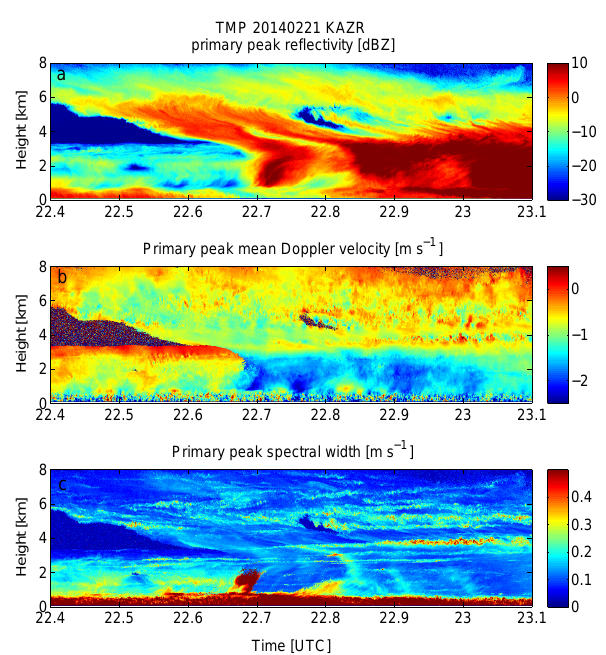
Figure 2. KAZR-observed primary Doppler spectrum peak mo- ments on 21 February 2014 in Hyytiälä. Panel (a) shows reflectivity (dBZ), (b) mean Doppler velocity (ms − 1 ) , and (c) spectrum width of the primary Doppler spectrum peak (ms − 1 ) . Negative Doppler velocities indicate downward